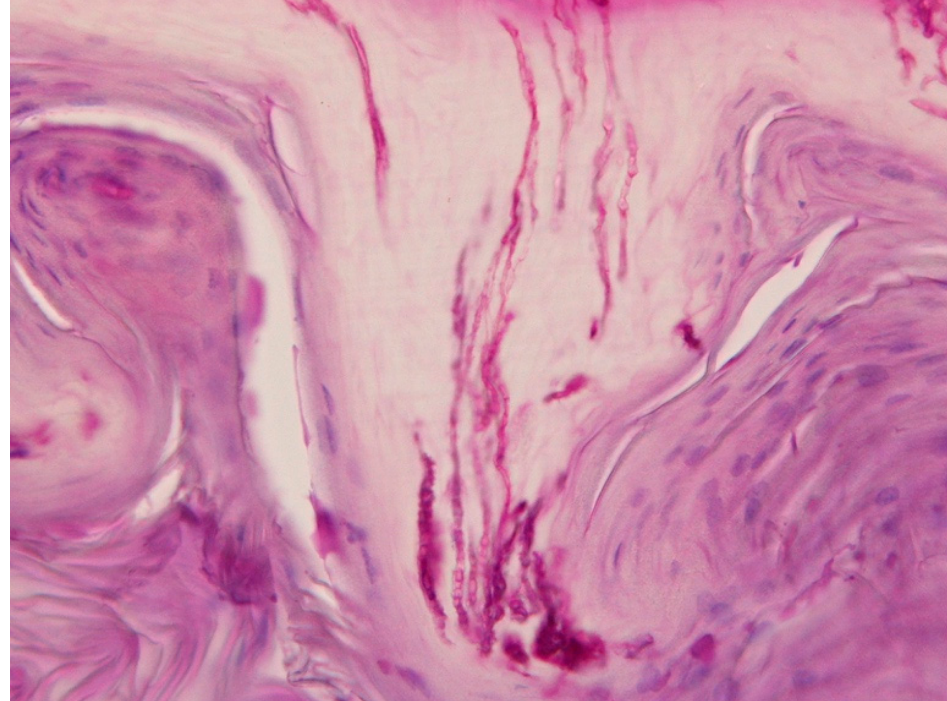
Figure 4. Histopathology of a nail clipping from the index finger of a 39-year-old female patient showing long slender filaments suggestive of dermatophyte hyphae. PAS stain, original magnification 400×.